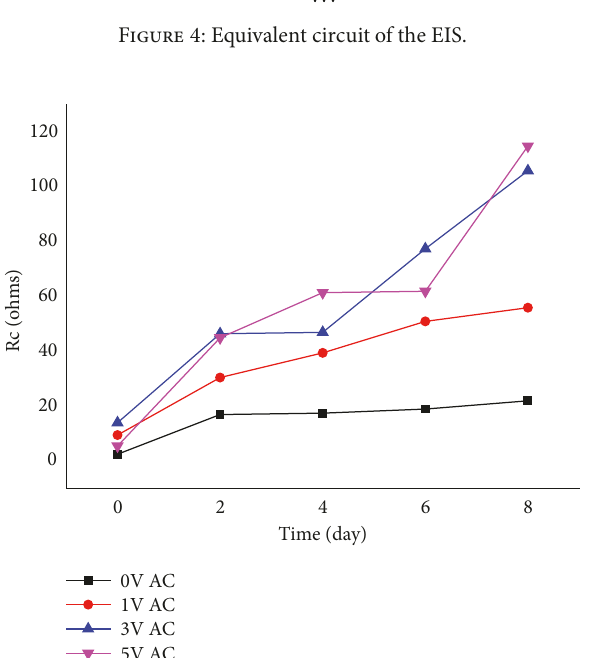
Figure 5: The Rc value of the sacrificial anode under different AC interference voltages at an ambient temperature of 20 ∘ C in the test